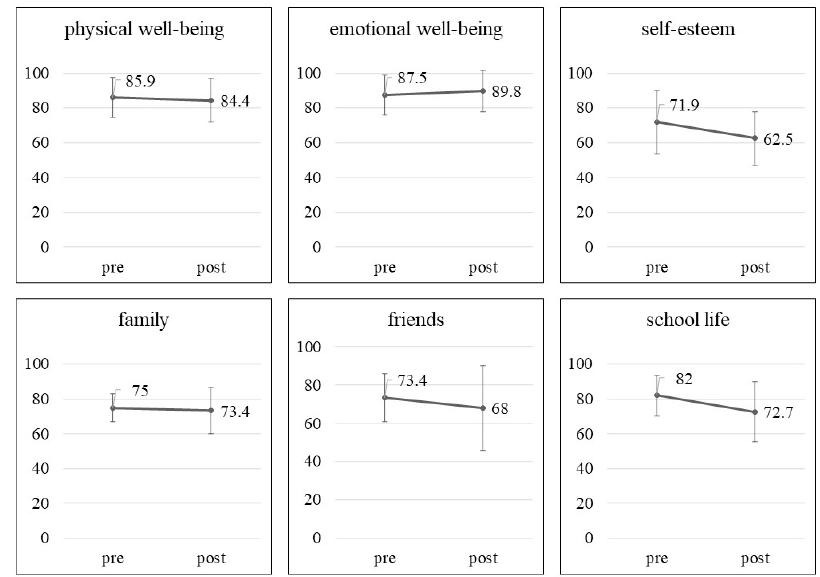
Figure 2. Changes in the Kid-KINDL subscale scores between baseline and 3 months after starting the Esports program in children with autism spectrum disorder. Wilcoxon signed-rank test: physical well-being, p = 0.87; emotional well-being, p = 0.56; self-esteem, p = 0.14; family, p = 0.66; friends, p = 0.77; school life, p = 0.17. Table 1. Change in the data that were derived from the evaluation instruments after the Esports program.